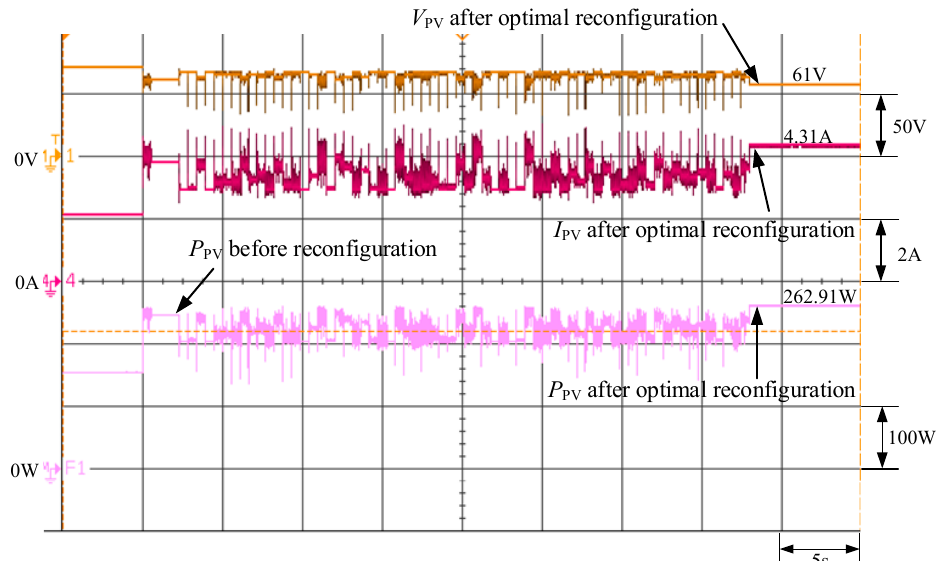
Figure 13. Response to an optimization request in a Case 2 array configuration.